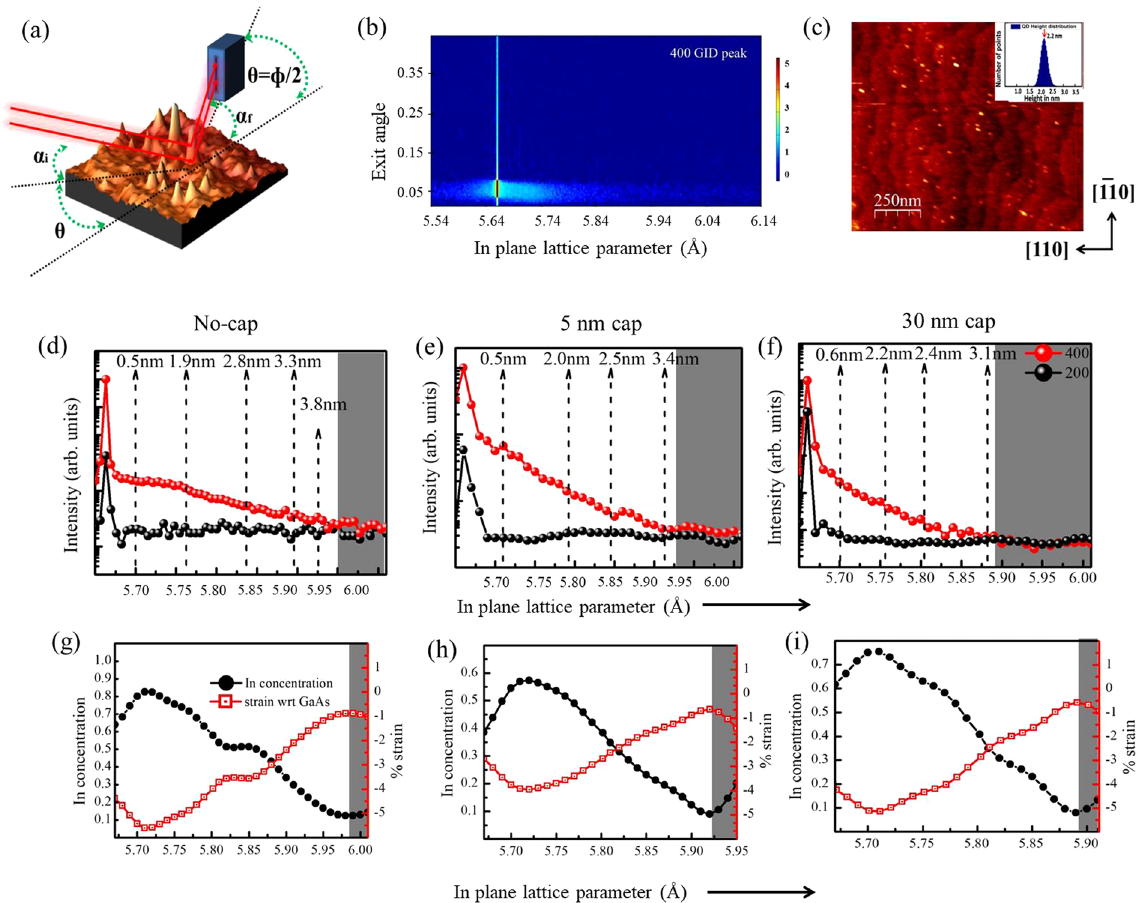
Figure 1. ( a ) Grazing incidence diffraction geometry used in the experiment. Here α is kept near the critical i angle of the substrate and θ is the incident in-plane angle on (400) and (200) planes and ɸ is the detector angle. Red arrows indicate directions of X-ray beams and the surface of uncapped QDs as seen in AFM is shown as sample. ( b ) GID intensity profile of InGaAs QDs on GaAs substrate around the (400) lattice plane of GaAs in which horizontal and vertical axes denote in-plane lattice parameter and exit angle of the Mythen detector respectively. ( c ) AFM image of uncapped InGaAs QDs shows elongation in [100] direction. Profile of scattered intensity (integrated over exit angle of Mythen detector) around (400) and (200) Bragg peaks of ( d ) uncapped and ( e ) 5 nm and ( f ) 30 nm GaAs capped InGaAs QDs. The in-plane lattice parameters of InGaAs QDs and corresponding heights have been indicated by the dashed line. Indium fraction within InGaAs QDs, in-plane strain with respect to the GaAs for ( g ) uncapped ( h ) 5 nm and ( i ) 30 nm GaAs capped QDs are also